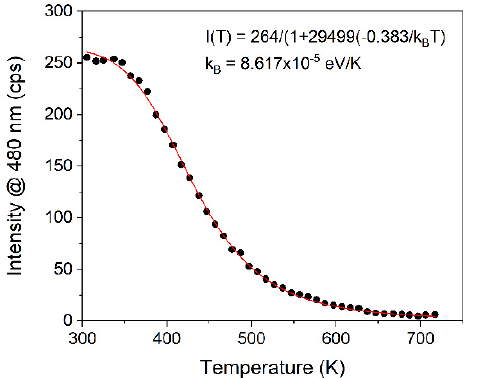
Figure 6. Selected RL spectra for Rb 4 Ge 5 O 9 F 6 :Nb up to 405 °C.